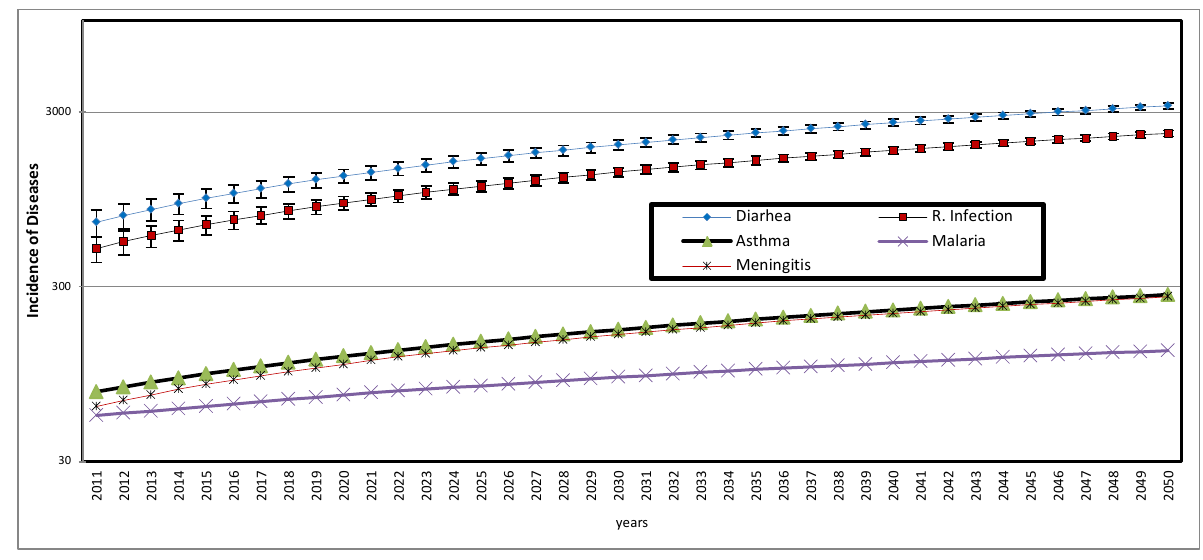
Figure 10. Projected distribution of diseases 2011 to 2050.